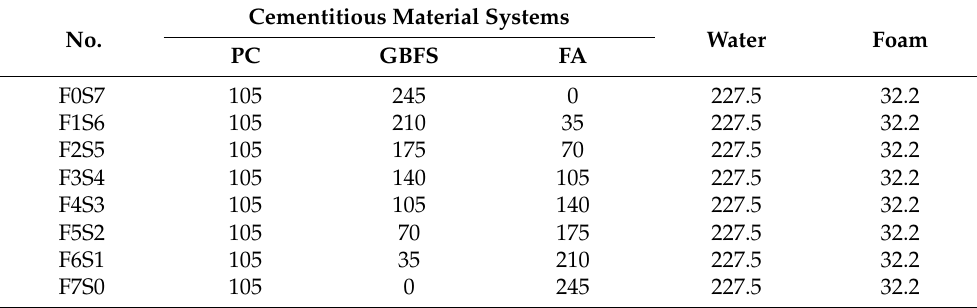
Table 3. Mix designs of LCFLS (kg/m 3 ).